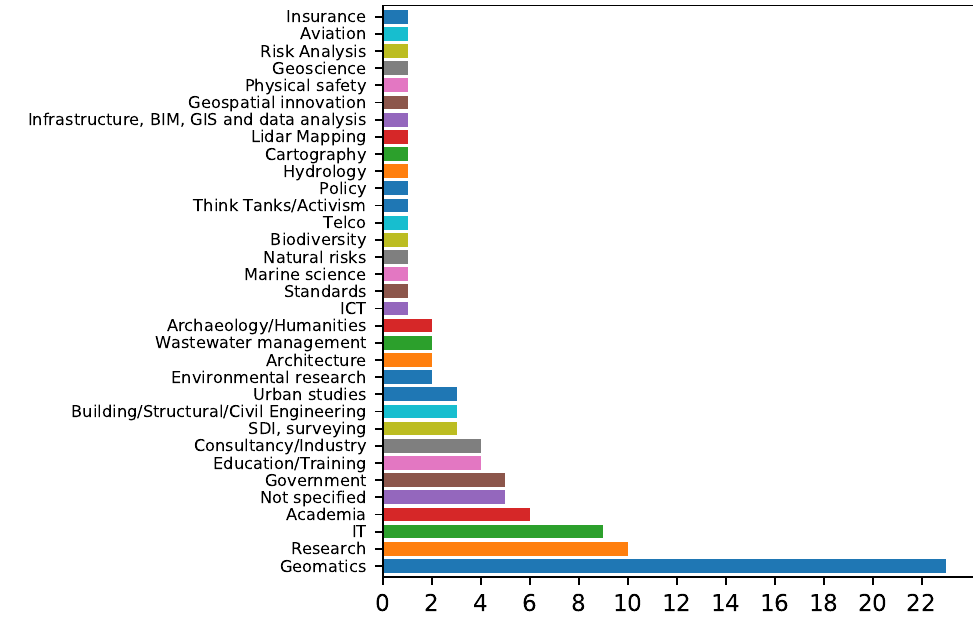
Figure 1. Distribution of the field/area of work of the participants (by